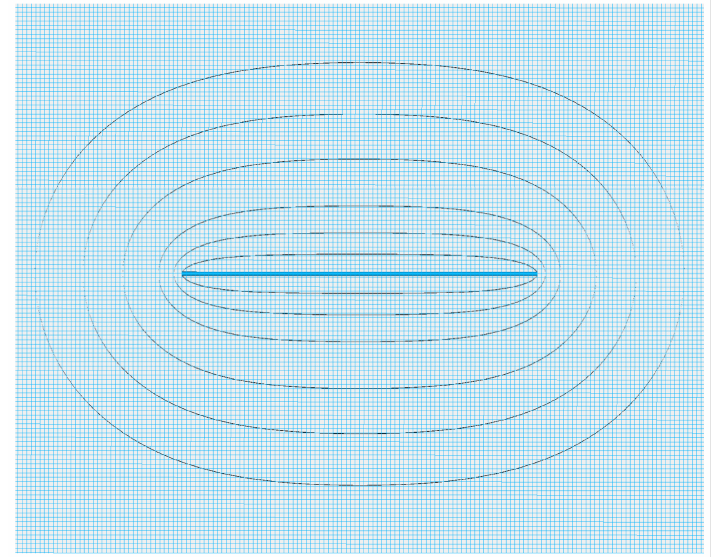
Figure 14. Pressure Iso-line Assumption in Developed Analytical Model for Transient Elliptical